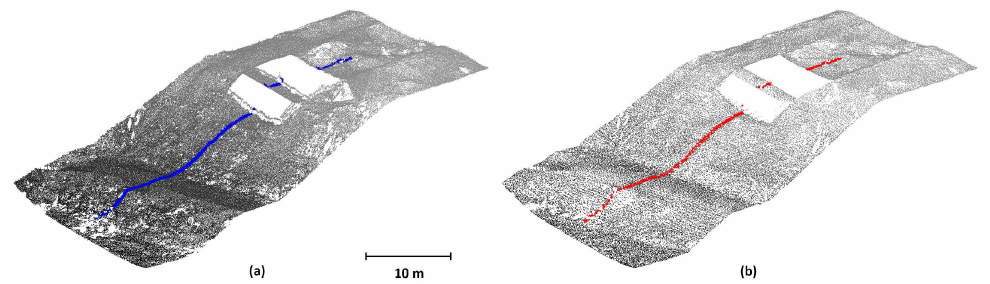
Figure 11. Site 4 ( a ) after CSF filtering and ( b ) after MDSR